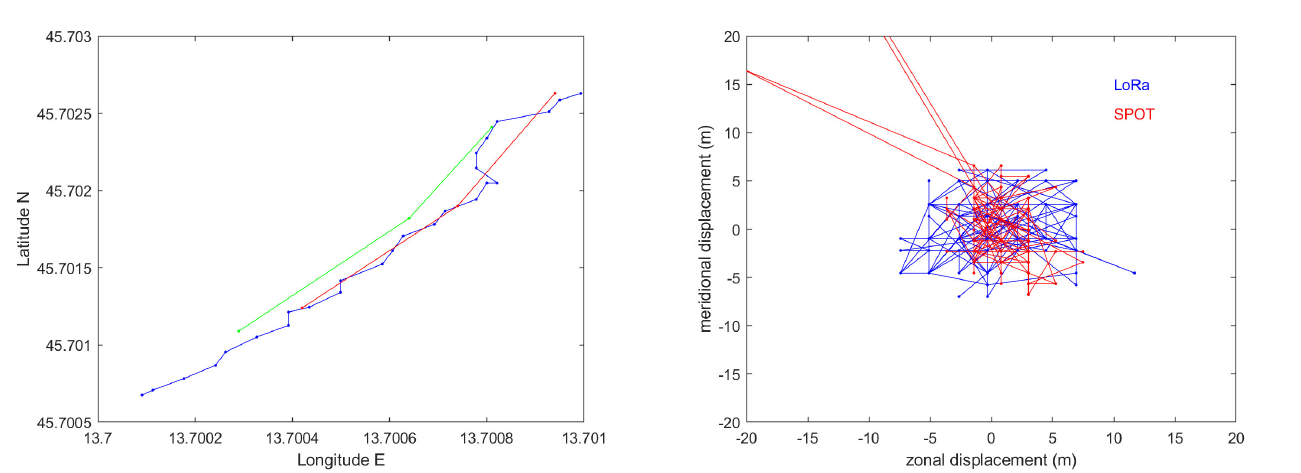
Figure 7. Drifter trajectories during the first phase of the experiment carried out in March 2018 (blue = Drifter 1 - LoRa data; red = Drifter 1 - SPOT data; green = Drifter 2 - SPOT data)